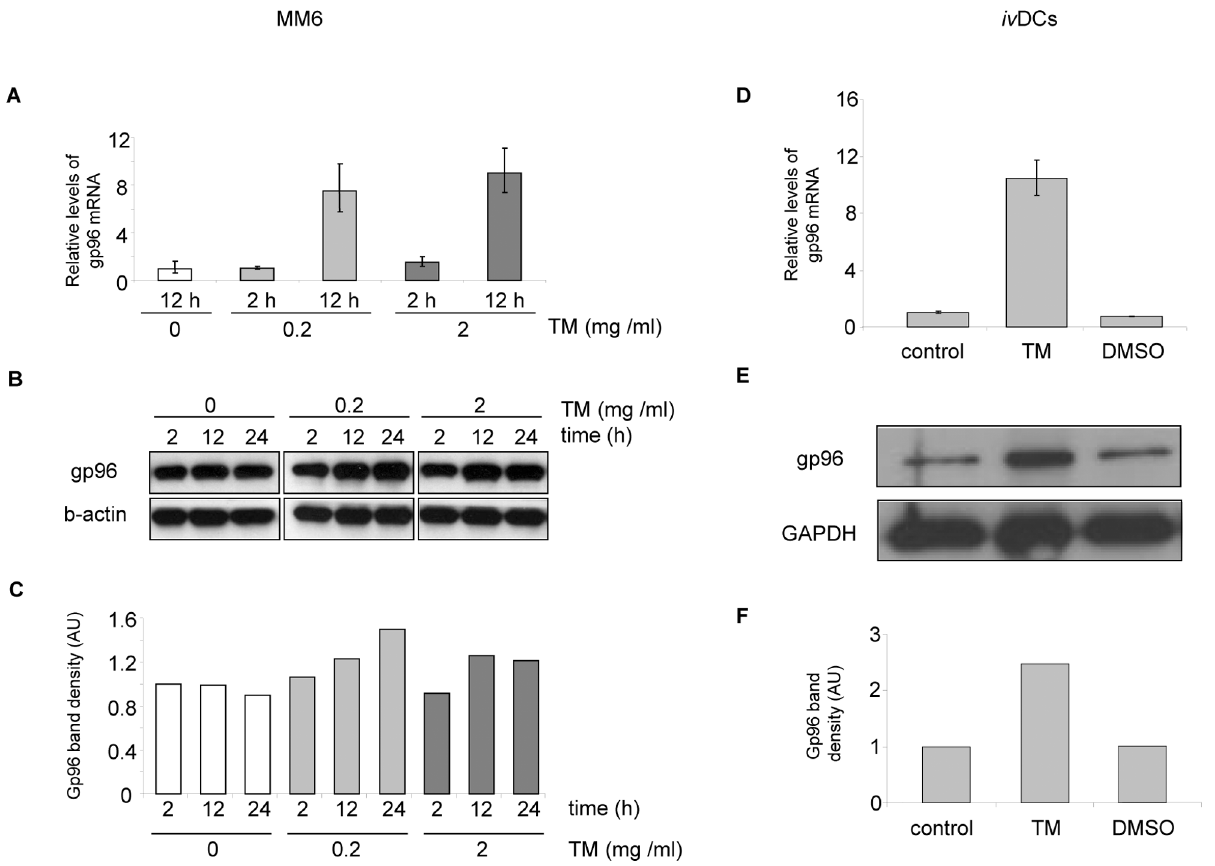
Figure 4. ER stress induction of gp96 in MM6 and i. v.DCs. Panels A–C show the results for MM6 after 2, 12, and 24 hours of incubation with tunicamycin, panels D-F for i. v.DCs after 24 hours. Results are representative for three experiments. Three concentrations of tunicamycin were used to induce ER-stress in MM6 cells: 0, 0.2, and 2 m g/mL. (A, D) Relative mRNA levels of gp96 (vs. b -actin). Error bars represent the standard deviation of a single experiment measured in triplicate. (B, E) Western blot analysis of gp96. (C, F) Densitometric analysis. AU: arbitrary